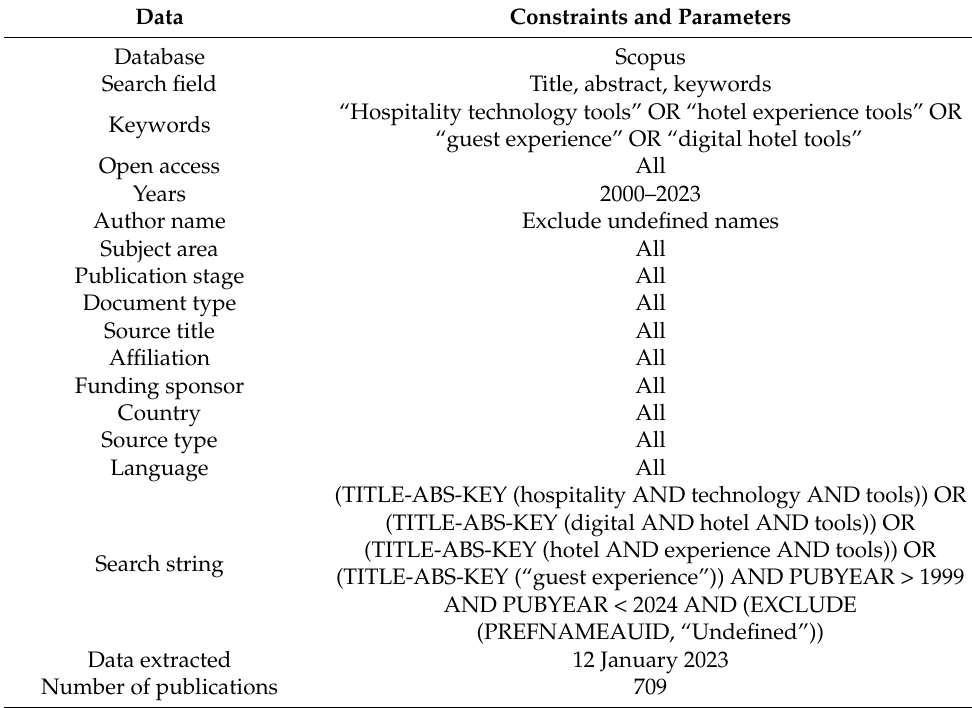
Table 1. Data retrieval constraints and parameters for the Scopus